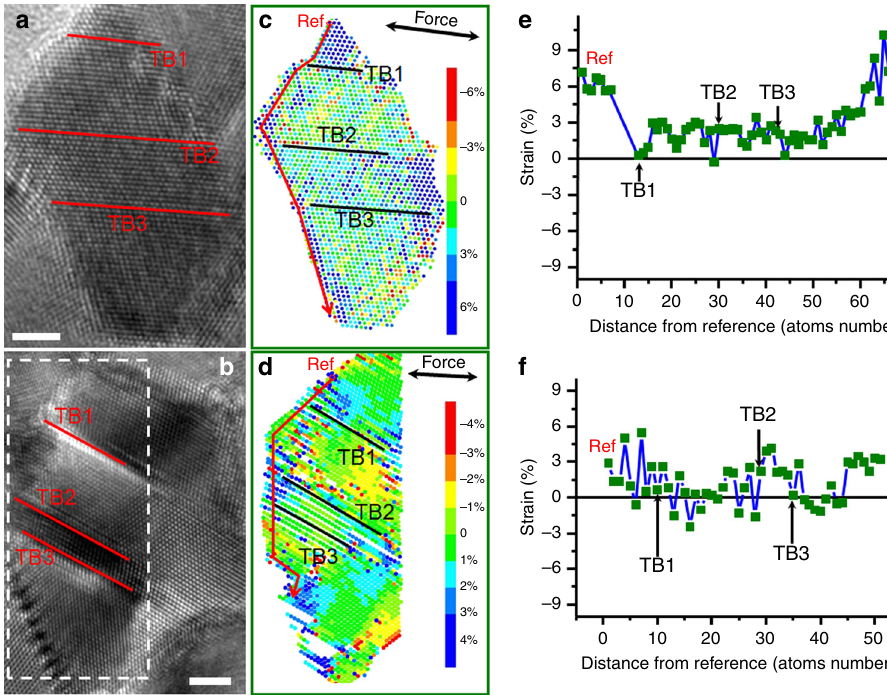
Fig. 6 Typical strain mapping of twin-structural grains. a, b Two HRTEM images of the twin-structured grains. c The strain mapping corresponds to a . d The strain mapping that corresponds to the framed region of b . As seen from the fi gures, the strain concentration can be observed both at the conventional GB and GB-TB intersections. e Quantitative strains extracted along the red line region of ( c ) by using intensity line scanning from top to bottom along the GB; the zero point is denoted by “ Ref ” . f Quantitative strains extracted along the red line region of ( d ) using intensity line scanning from top to bottom along the GB; the zero point is denoted by “ Ref ” . The scale bars are for 2